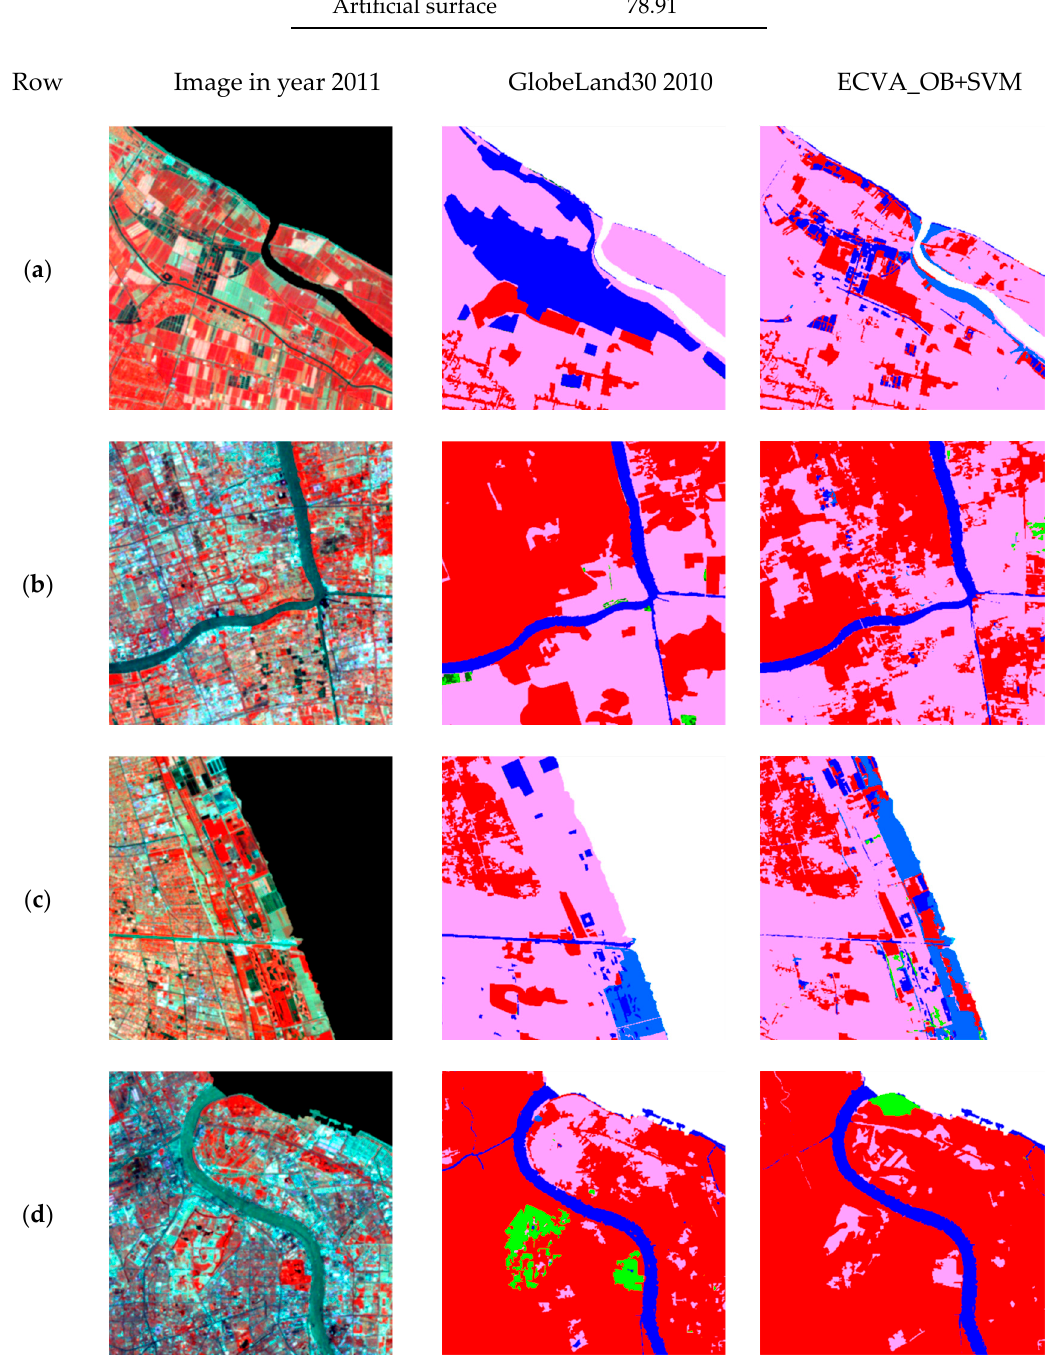
Figure 9. Examples of disagreements between the updating results generated by ECVA_OB + SVM and GlobeLand30 2010. Table 4. Per ‐ pixel agreement between generated updating result by ECVA_OB+SVM and GlobeLand30 2010.